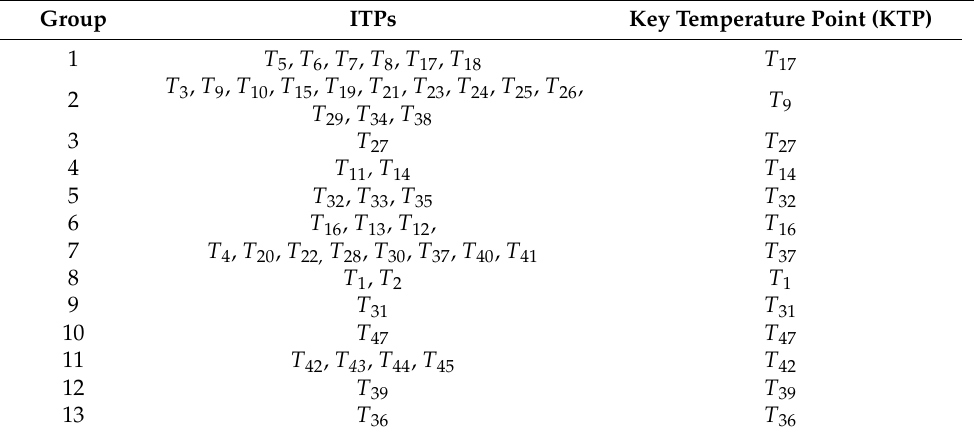
Table 7. Final ITP clustering results.